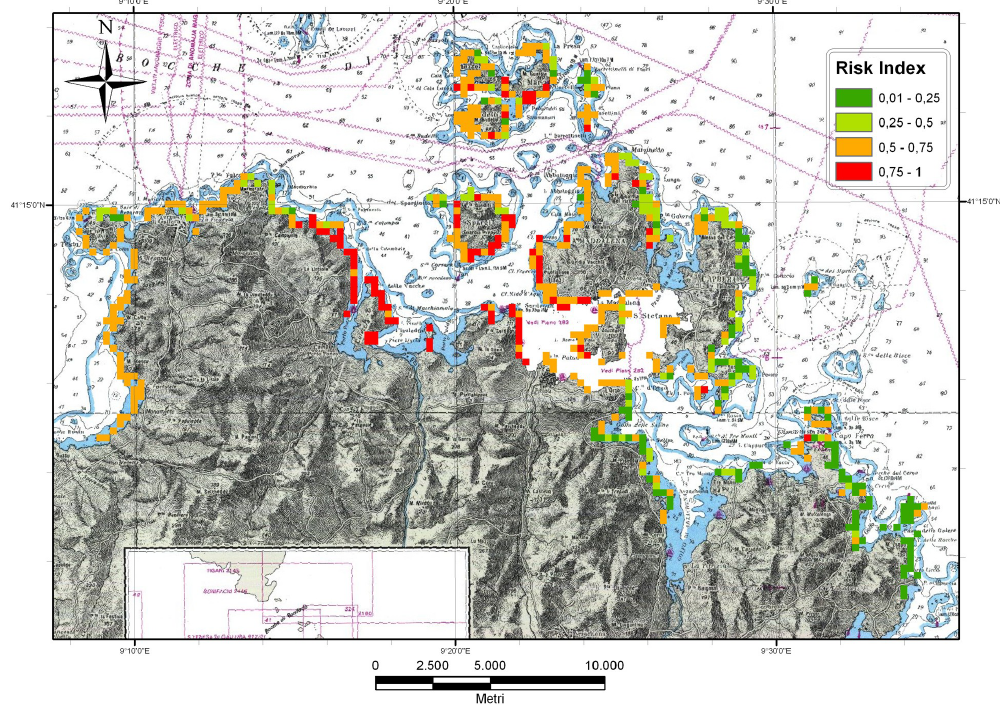
Fig. 10. Risk map of oil impact on the coast as consequence of a potential release from